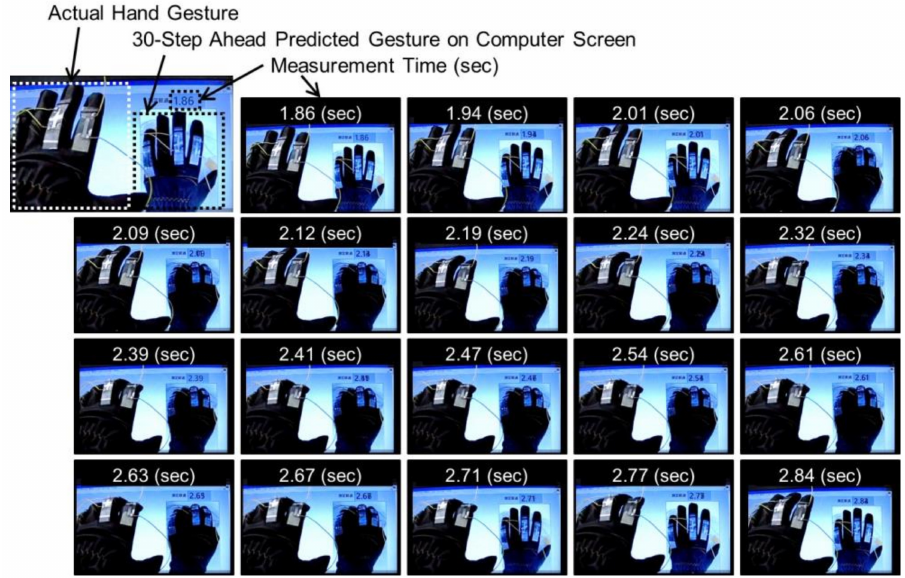
Figure 9. Visualization of the 30-step-ahead predicted gesture obtained from TDNN